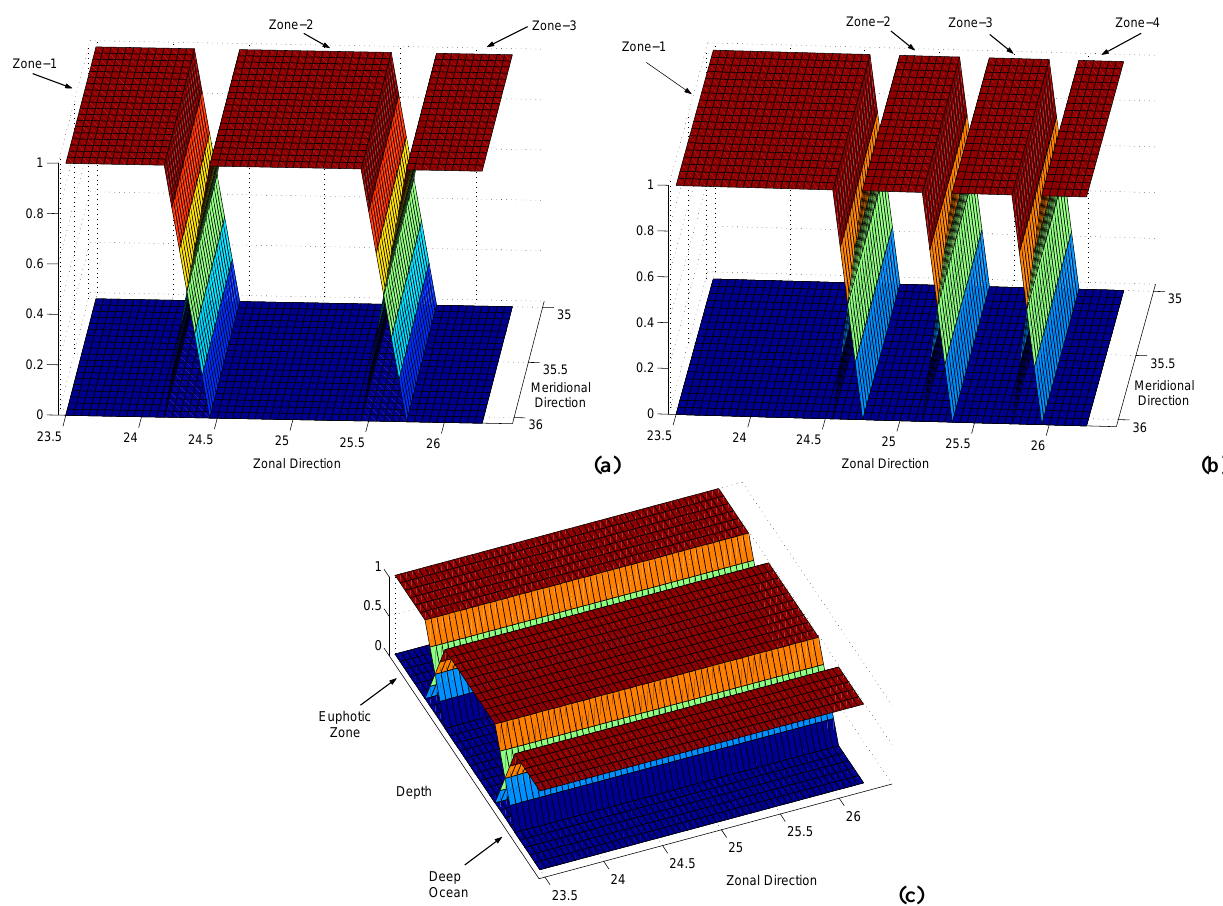
Fig. 4. Model domain decomposition into 3 and 4 horizontal sub-domains and 3 vertical sub-domains.